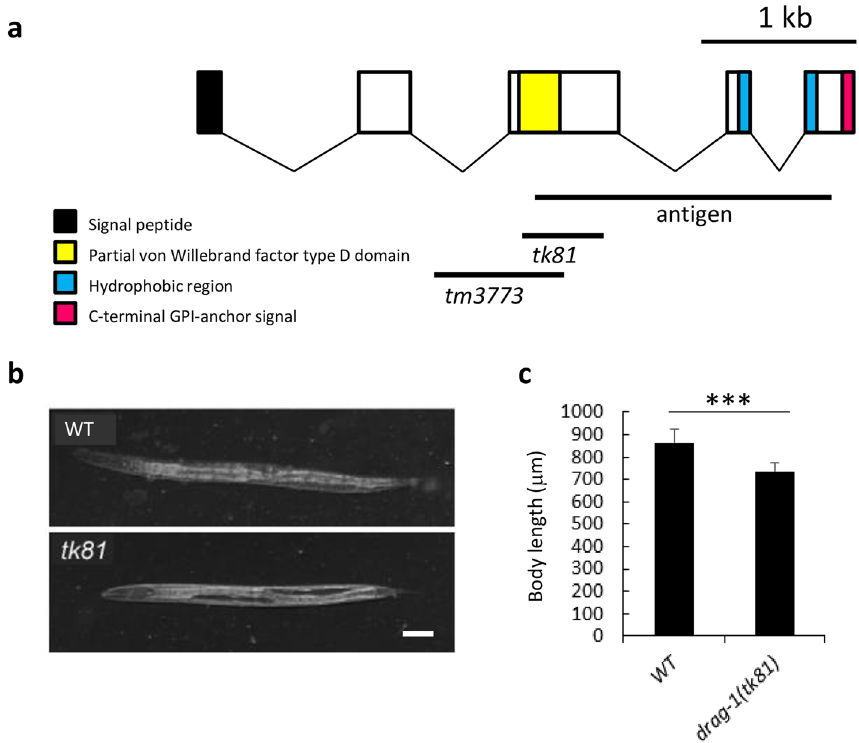
Figure 1. Gene structure and mutant phenotype of drag-1 animals. ( a ) Structure of drag-1 and mutation sites of the tk81 and tm3773 alleles. The exon and intron regions were determined by sequencing cDNA generated from isolated drag-1 mRNA. Black, yellow, blue, and magenta boxes indicate N-terminal signal peptide, partial von Willebrand factor type D domain, hydrophobic region, and C-terminal GPI-anchor signal sequence, respectively 15 . Bars depict the region of the cDNA used for expressing the antigenic peptide for producing antibodies and the respective mutation sites. tk81 is a 494-bp deletion within exon 3, which is expected to produce a truncated polypeptide that is missing the C-terminal 278 amino acids. tm3773 is an 892-bp deletion spanning from intron 2 to exon 3 (WormBase). ( b ) Body length phenotype of drag-1(tk81) mutants. Body length of young adult hermaphrodites. tk81 mutants had shorter bodies compared with wild type. Anterior is to the left. Scale bar: 50 μm. ( c ) Quantification of body length of young adult hermaphrodites for wild-type and drag-1 mutant animals. Significant difference was determined by Student’s t-test. ***P < 0.001. n = 60 for each